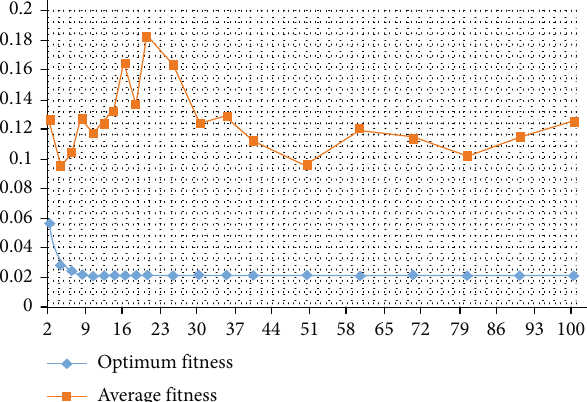
Figure 5: Particle swarm optimization simulation